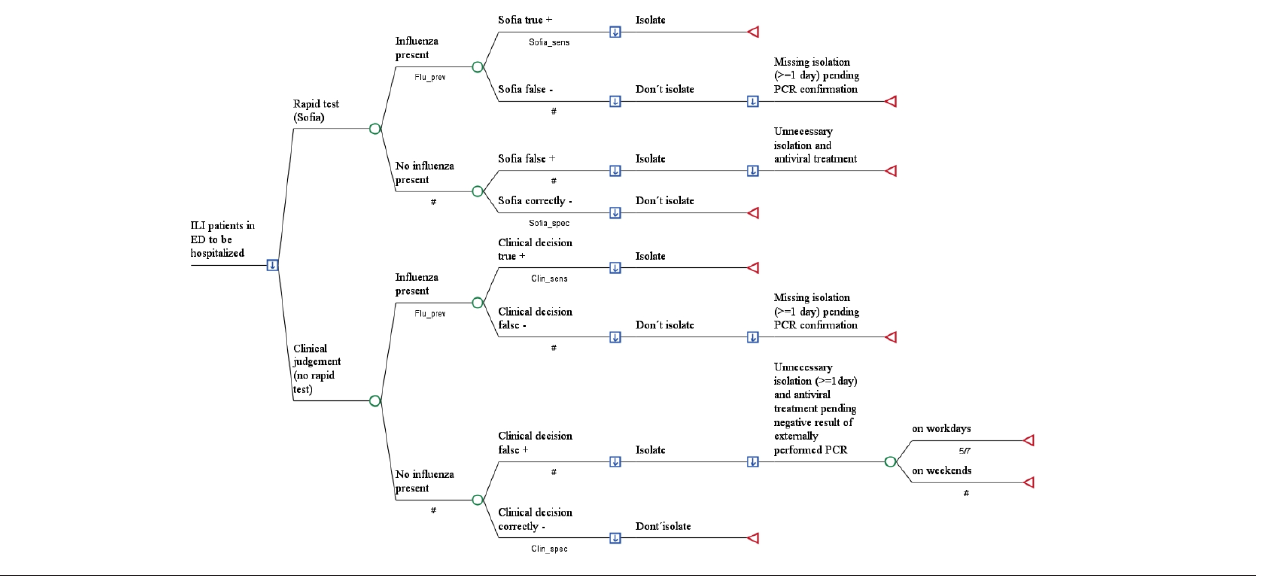
Legend to figure 1: A decision node (square) indicates a choice facing the decision maker or the consequences of a decision. Branches from a chance node (circles) represent the possible outcomes of an event; terminal nodes (triangles) denote the endpoints of a scenario and are assigned the costs of a prior series of actions and events. The arrows in the decision notes pointing downwards demonstrate that the optimal path of the model is that with the lowest total cost. #: Complementary probability (all probabilities of chance node’s branches to sum to 1.0); +: positive; -: negative. ED: Emergency